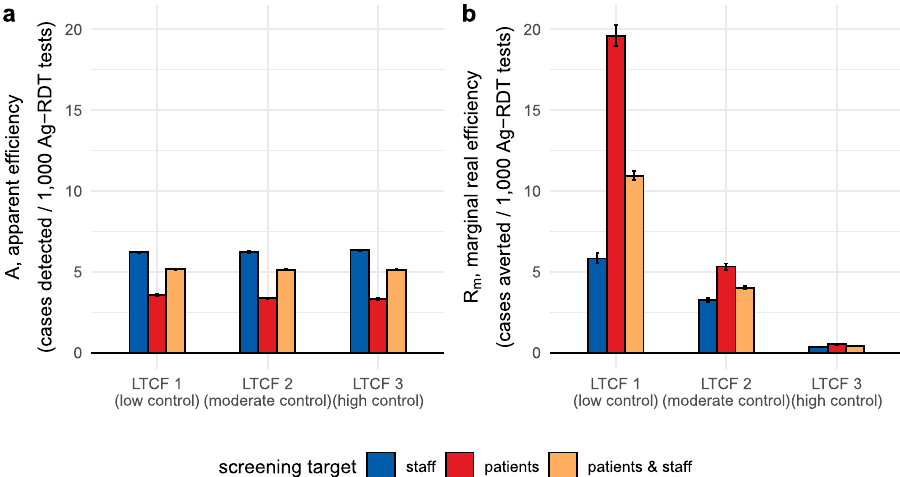
Fig. 3 Ef fi ciency of Ag-RDT screening: infection detection versus infection prevention. Ef fi ciency of Ag-RDT screening in the context of a highly effective surveillance strategy (intervention #23, routine RT-PCR testing + 2-round Ag-RDT screening on days 1 and 5), comparing ( a ) apparent screening ef fi ciency with ( b ) marginal real screening ef fi ciency. Marginal real screening ef fi ciency describes ef fi ciency of Ag-RDT screening for prevention of remaining nosocomial SARS-CoV-2 infections not already averted by routine RT-PCR testing. Screening interventions targeted either all members of staff (blue), all patients (red), or all individuals in the LTCF (orange). Baseline assumptions underlying simulations include: “ low ” community SARS-CoV-2 incidence and time-varying Ag-RDT sensitivity relative to RT-PCR (Ag-RDT A). Bar heights and error bars correspond to means and 95% con fi dence intervals estimated by bootstrap resampling ( n = 10,000). RT-PCR = reverse transcriptase polymerase chain reaction; Ag-RDT = antigen rapid diagnostic